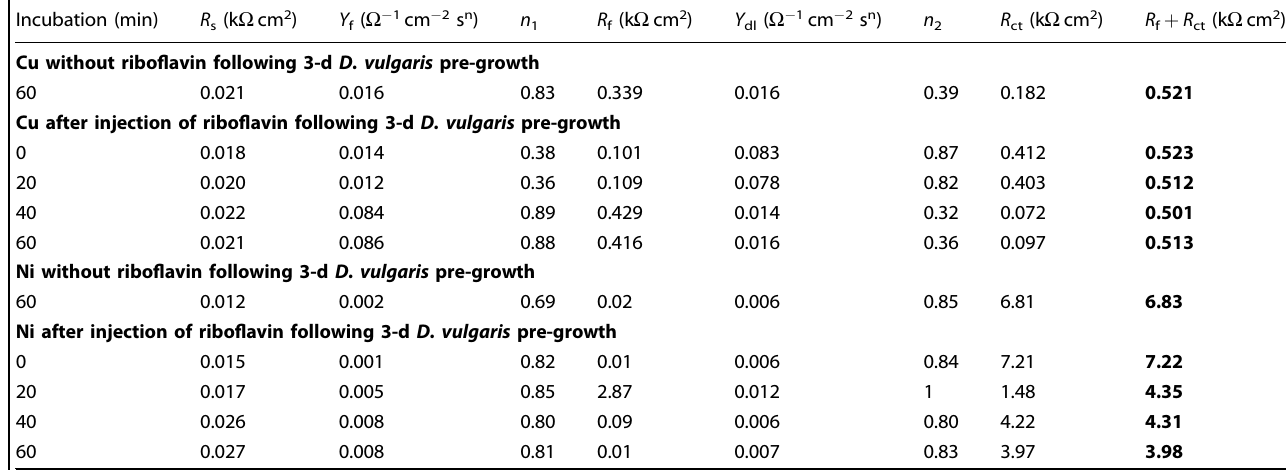
Table 3. Fitted electrochemical parameters from EIS data in Fig. 13. Incubation